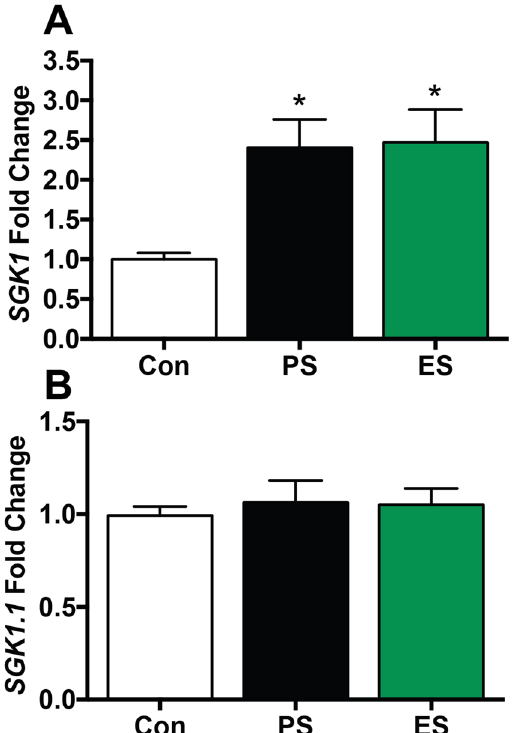
Figure 7. CSDS increased VTA SGK1 gene expression. ( A ) VTA SGK1 expression was significantly increased in both PS and ES mice compared to non-stressed controls. ( B ) However, expression of the brain-specific SGK1 isoform, SGK1.1 , did not differ between groups. n = 11–25 mice/ group; * p < 0.05 compared to control, Tukey’s post-hoc